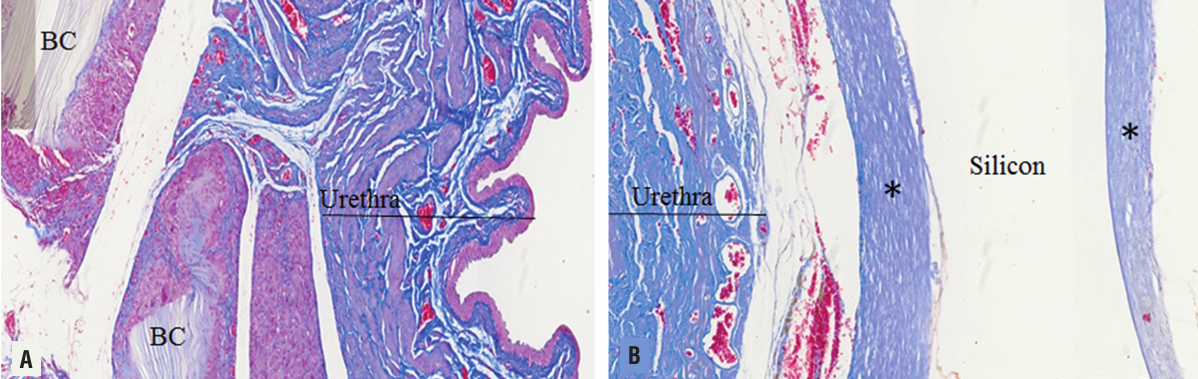
Figure 4 - Photomicrography of collagen deposition in bacterial cellulose implants (A) and silicone implants (B), both after 8 months. Masson’s Trichrome Staining Protocol for Collagen Fibers (20X). *Thick collagen fibers. Note: Silicone implants did not resist the histological processing, for that reason the area appears as an empty